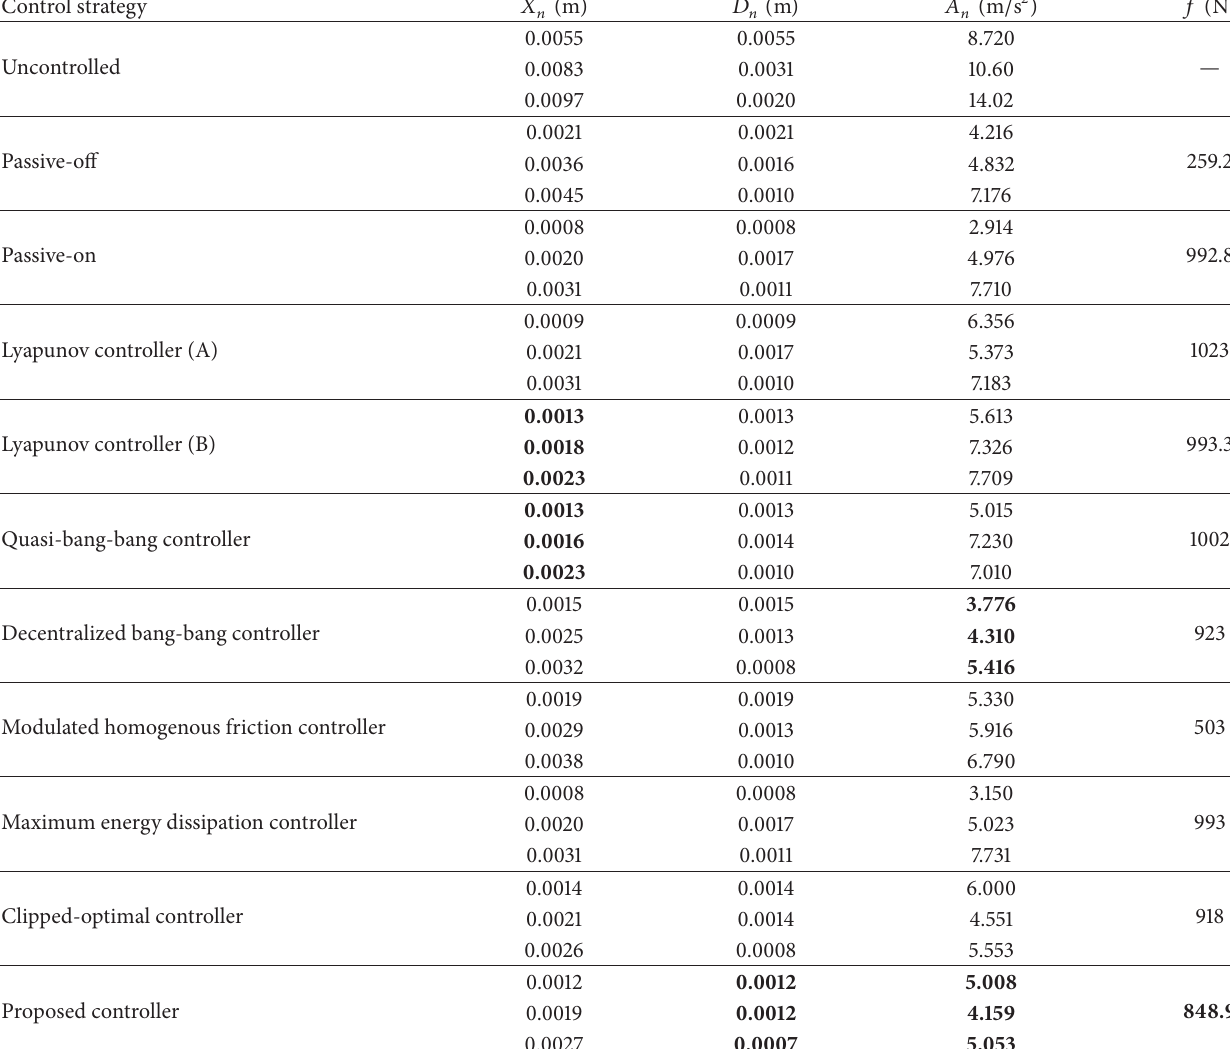
Table 1: Peak responses of the three-story building model under El Centro earthquake